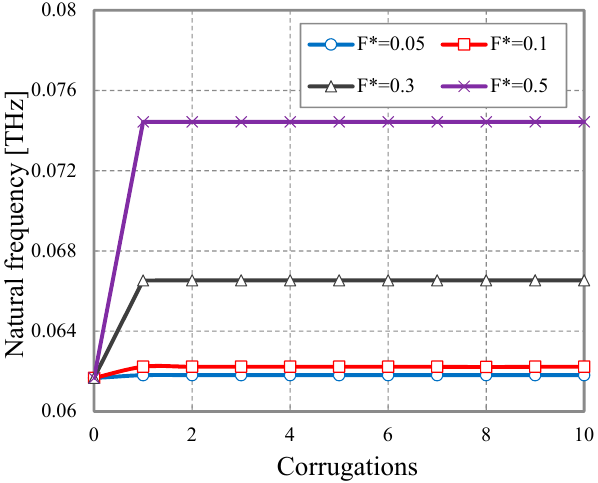
Figure 3. Natural frequency vs. number of corrugations. l ∗ = 0.5, µ = 1.41 nm 2 , g = 0.5 Ns/m 2 .